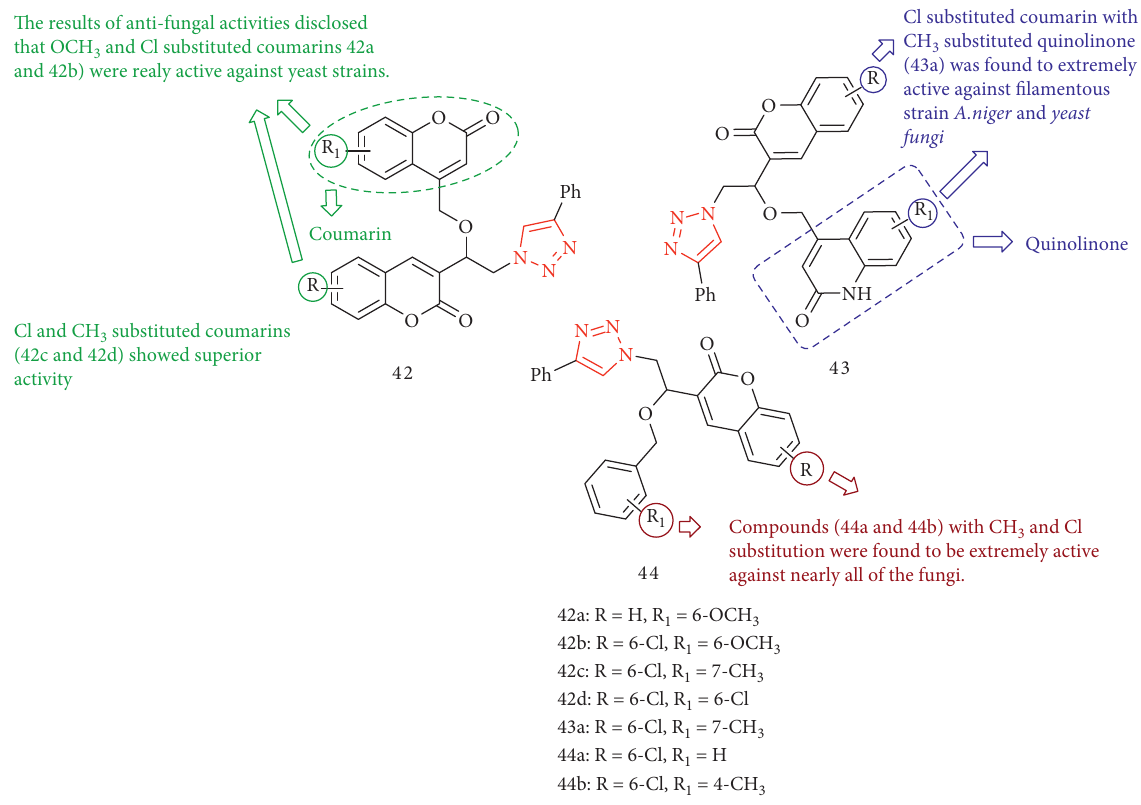
Figure 5: Chemical structure of coumarin, quinolinone-linked